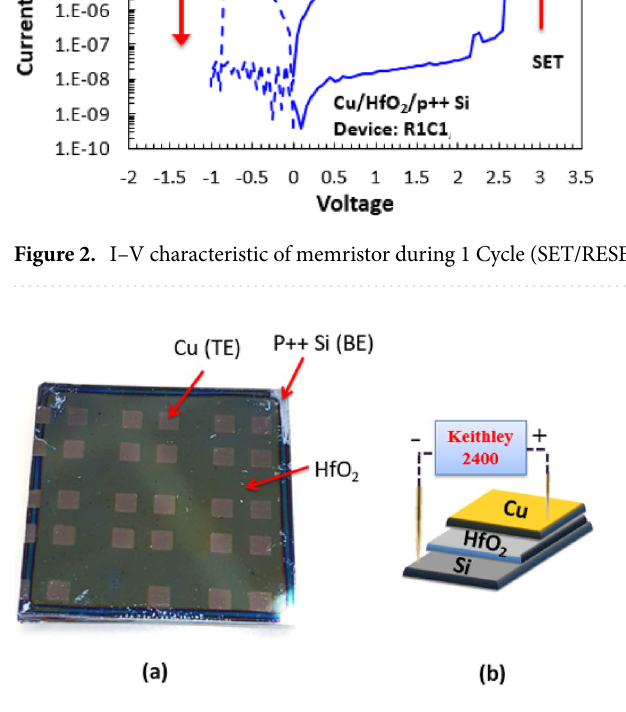
Figure 3. ( a ) Photo of one of the fabricated wafers with memristor devices ( b ) Schematic illustration of the HfO 2 memristor showing the stacked layers and the orthogonal alignment of the top and bottom